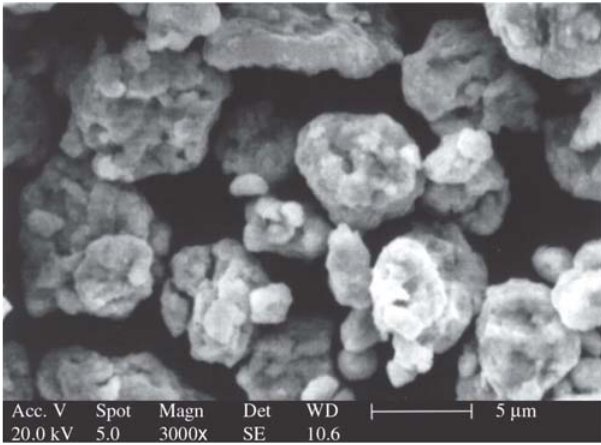
Figure 9. Scanning electron micrograph of Cu-13Al-2Nb milled for 12 hours with a